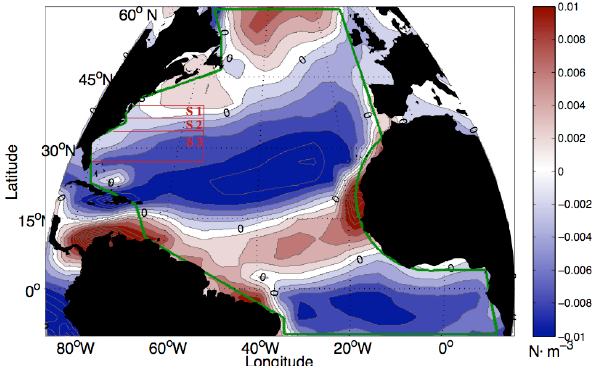
Fig. 1. Domain of model integration (delimited by the green curve) and climatological surface wind-stress curl obtained from 41 years (1961–2001) of ECMWF wind-velocity fields retrieved from the ERA-40 re-analysis project. S1, S2, and S3 indicate sectors in which the flow kinetic energy is integrated to obtain the time se- ries shown in Figs. 4 and 9.